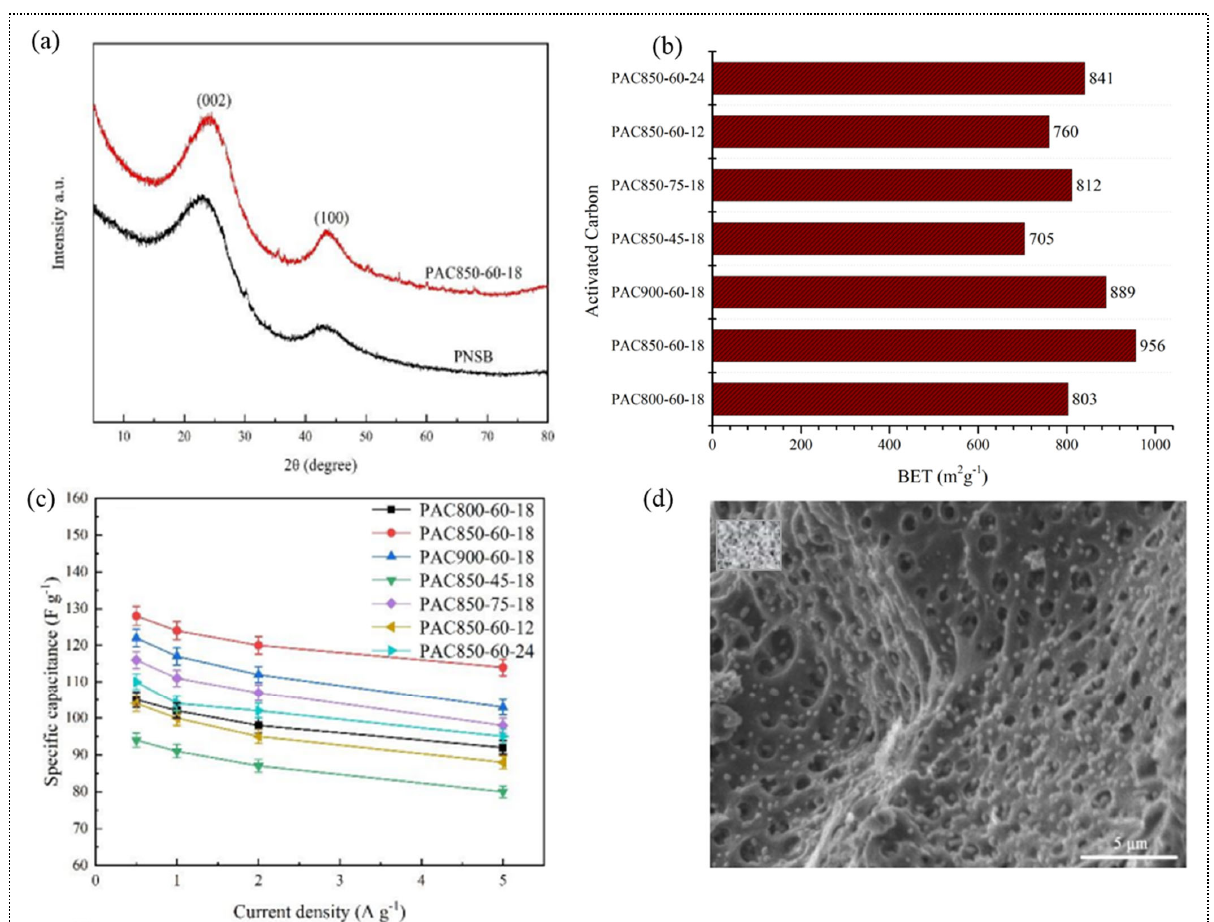
Figure 5. Physical activation of pine nut shell biochar using steam as an activating agent ( a ) XRD pattern. ( b ) BET analysis; ( c ) specific capacitance; ( d ) SEM micrograph. Reprinted with permission from Ref. [70]. Copyright 2019 ESG Publishing.